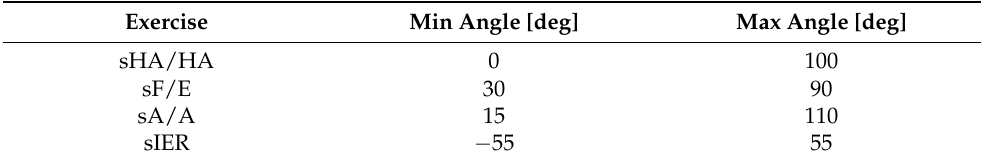
Table 6. List of the ROM for the physiological